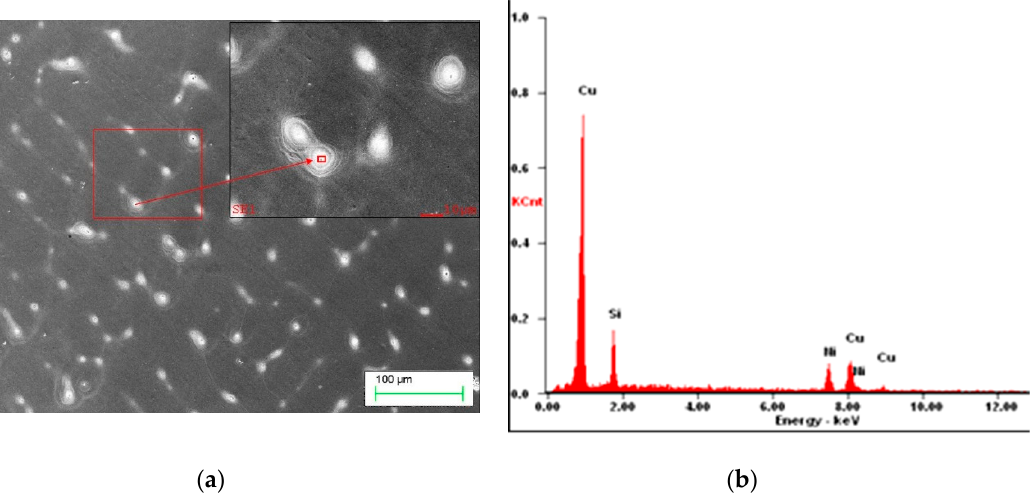
Figure 4. Microstructure of Cu–2Ni–1Si, initial state. Cooling rate 2.2 °C s − 1 ( a ), energy-dispersive X-ray spectroscopy (EDS) analysis in microarea, mass concentration, %: Si 9.09; Ni 30.55; Cu 60.35 ( b ).